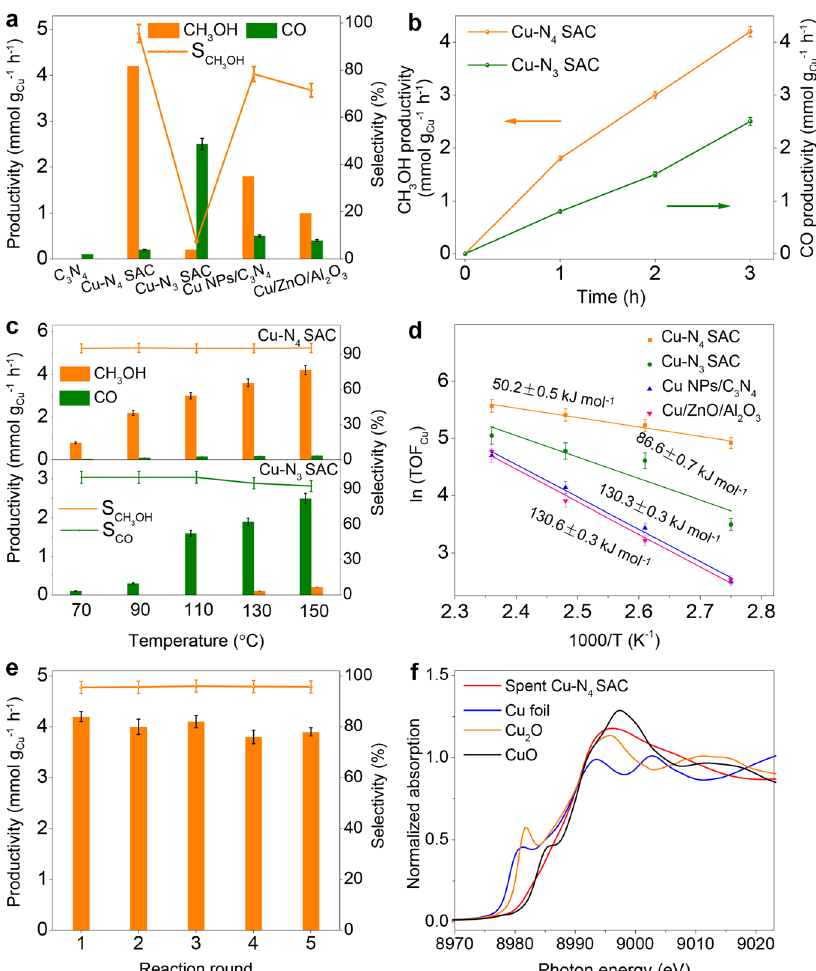
Fig. 3 Catalytic performance of CO 2 hydrogenation. a Catalytic performance of CO 2 hydrogenation over different catalysts. b CH 3 OH and CO productivities of Cu – N 3 SAC and Cu – N 4 SAC, respectively. Reaction conditions for ( a ) and ( b ): H 2 /CO 2 /N 2 = 72:24:4 vol.%, P total = 3.2 MPa, T = 150 °C, and reaction time is 3 h. c CO 2 hydrogenation over Cu – N 4 and Cu – N 3 SACs at different temperatures. Reaction conditions: H 2 /CO 2 /N 2 = 72:24:4 vol.%, P = 3.2 MPa, T = 70 – 150 °C, and reaction time is 3 h. d Arrhenius plots of different catalysts. e CH total cycles. Reaction conditions: H 2 /CO 2 /N 2 = 72:24:4 vol.%, P total = 3.2 MPa, T = 150 °C, and the reaction time for each cycle is 3 h. f XANES spectra of the spent Cu – N 4 SAC. All the data in ( a – e ) were collected for three times, and the error bars represent the standard deviation. Source data are provided as